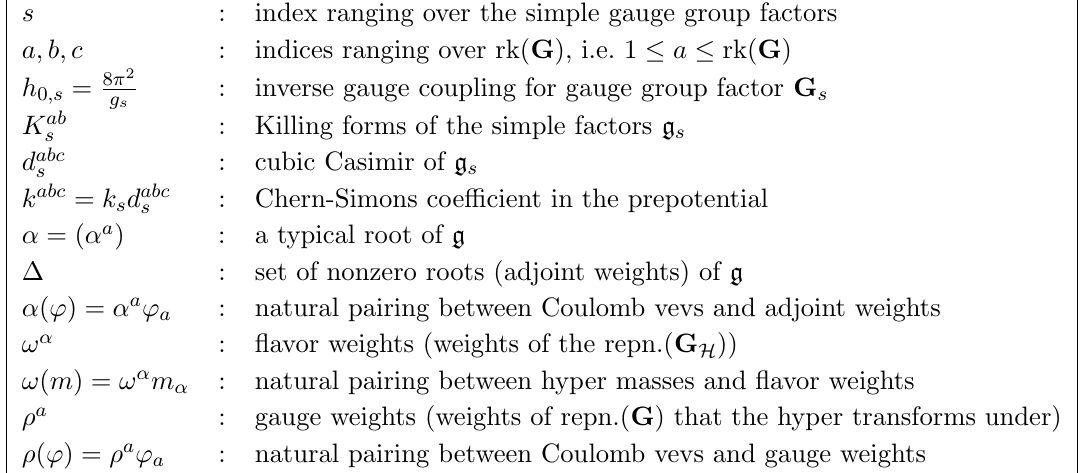
Table 1 . Notation for symbols appearing in the